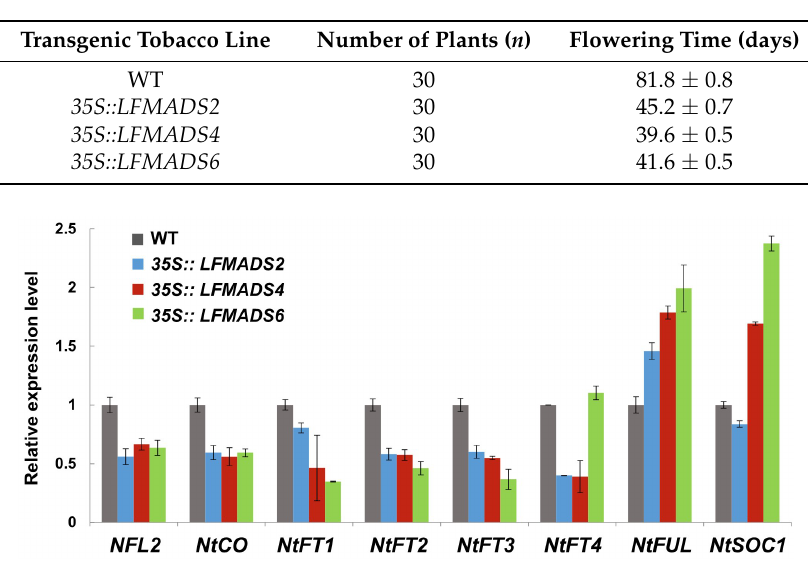
Table 3. Flowering time of the 35S::LFMADS2 , 35S::LFMADS4 , and 35S::LFMADS6 transgenic tobacco plants under long-day (16 h light/8 h dark) conditions.